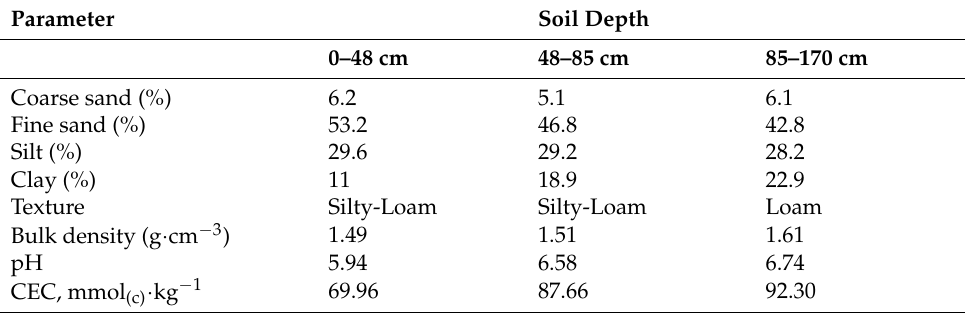
Table 3. The physical and chemical characteristics of the soil [15].